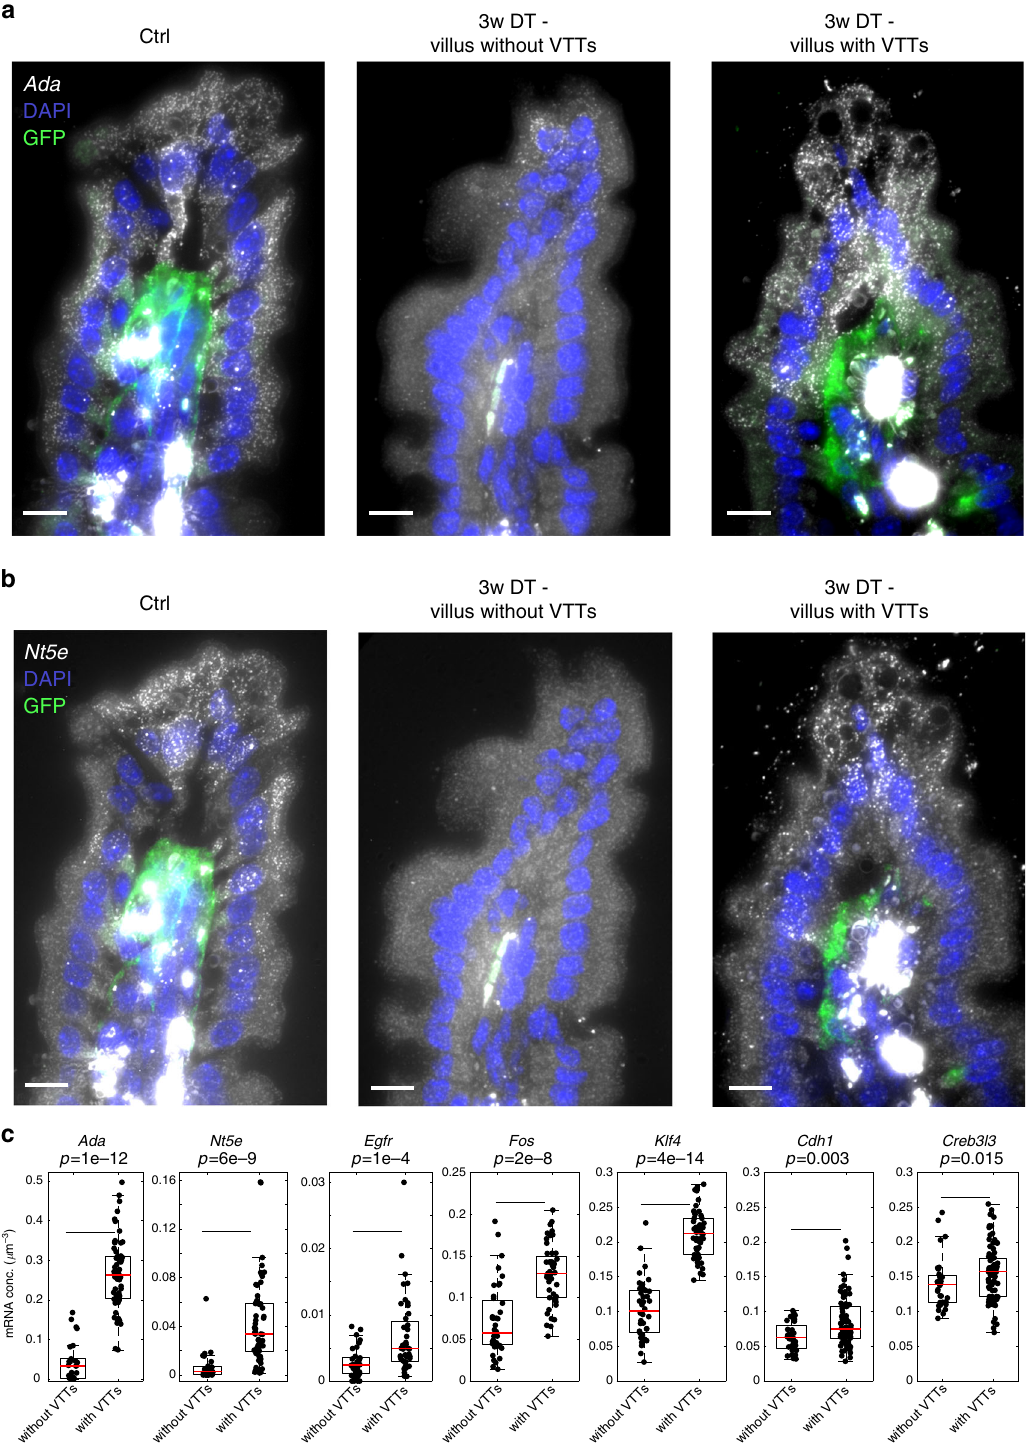
Fig. 7 Analysis of the villus tip epithelial cells of Lgr5 – GFP-DTR 3 weeks after VTT ablation shows correlation between the re-appearance of VTTs and the expression of enterocyte tip genes. a smFISH example of Ada showing higher expression in the villus tip with VTTs compared to villus tip without VTTs after 3 weeks. Scale bar 10 µ m. b smFISH example of Nt5e showing higher expression in the villus tip with VTTs compared to villus tip without VTTs after 3 weeks. Scale bar 10 µ m. c Quanti fi cation of expression differences between villi with VTTs and villi without VTTs. Measurements were performed over 15 villi per mouse for two mice. Indicated p values were calculated by two-sided Wilcoxon rank sum test. Boxes show 25 – 75 percentiles of the smFISH expression, horizontal red lines are medians, whiskers extend to the most extreme data point within 1.5× the interquartile range (IQR) from the